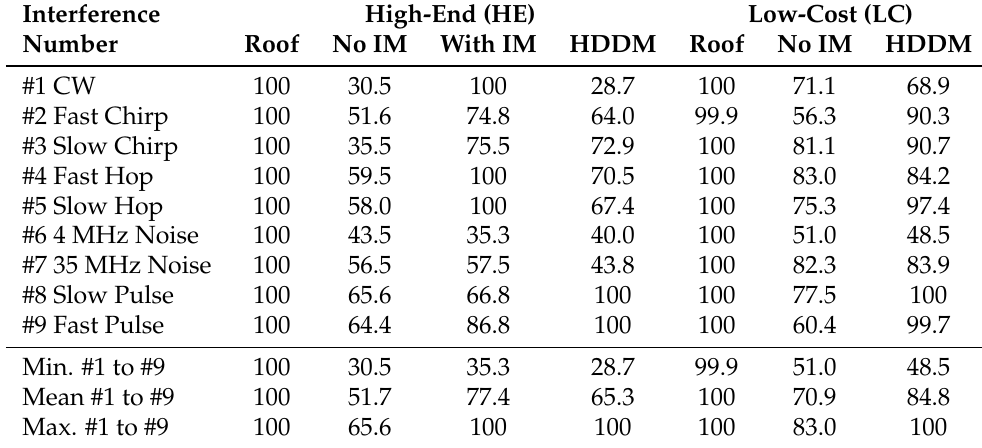
Figure 13. Interference #2 (fast chirp): 10MHz bandwidth and chirp repetition rate of 10µs. ( a ) Hori- zontal error over time. ( b ) Horizontal error CDF. Table 2. Percent